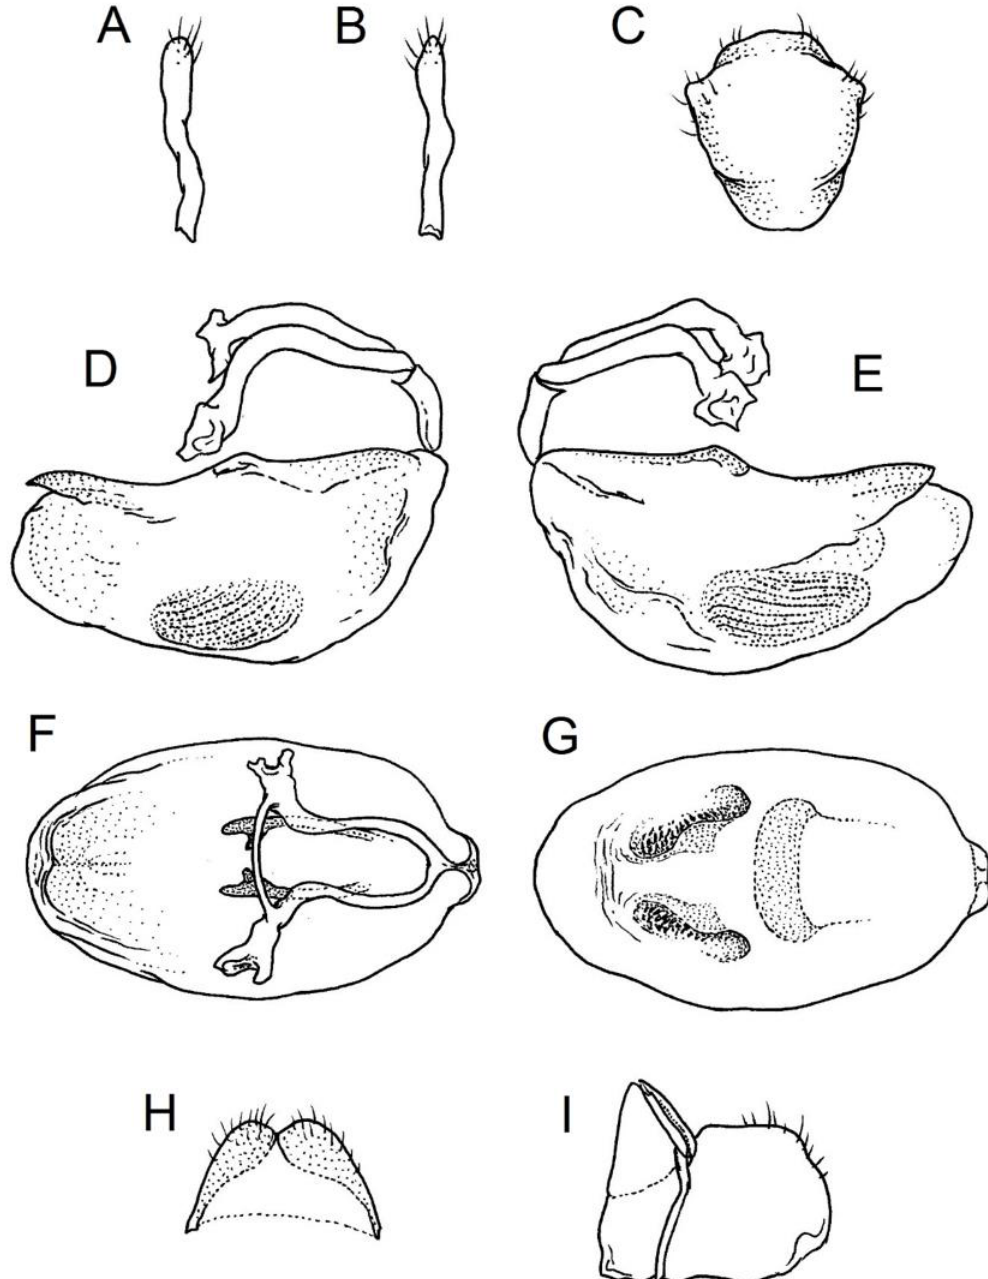
Figure 57. Phonoctonus principalis Gerstaecker, 1892: ( A ) left paramere; ( B ) right paramere; ( C ) pygophore, ventral view; ( D ) aedeagus, right lateral view; ( E ) aedeagus, left lateral view; ( F ) aedeagus, dorsal view; ( G ) aedeagus, ventral view; ( H ) styloids, outer view; ( I ) gonocoxite of abdominal segment VIII. Redescription